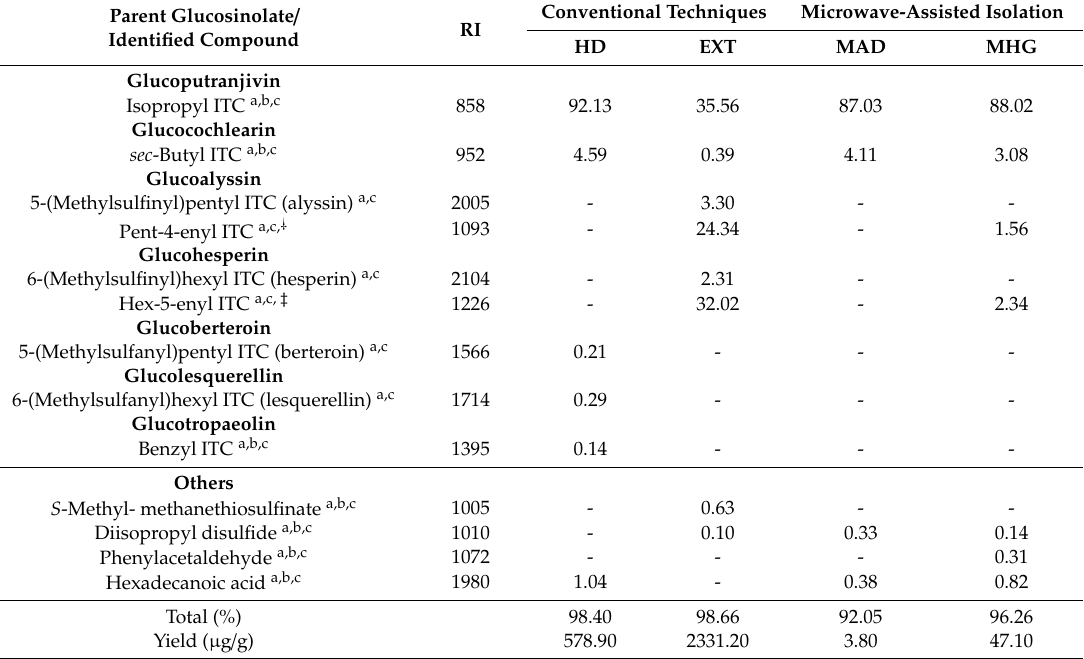
Table 2. Degradation volatile products, their parent glucosinolates, and others identified by GC-MS of L. annua volatile isolates. Parent Glucosinolate/ Conventional Techniques L. annua volatile isolates.